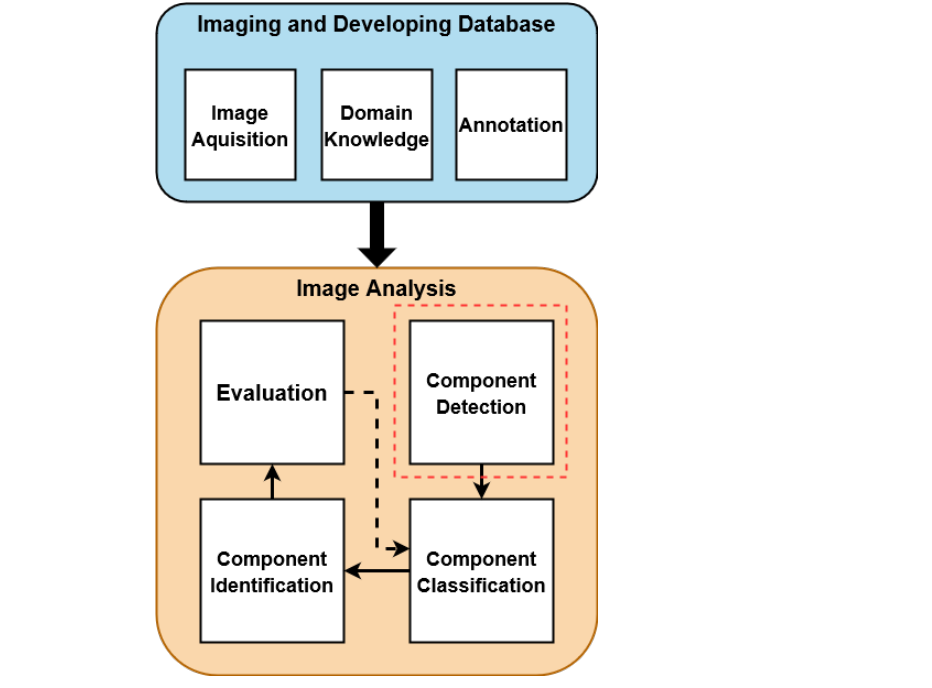
Figure 1. The framework for bill of materials extraction for PCB assurance as proposed in